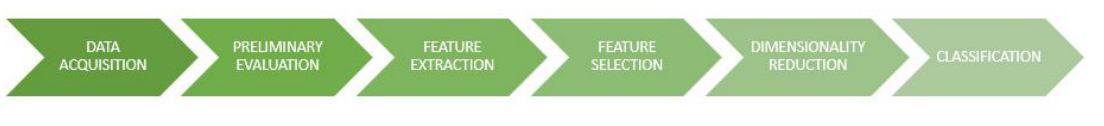
Figure 1. Schematic of the steps employed for the implementation of the algorithm.